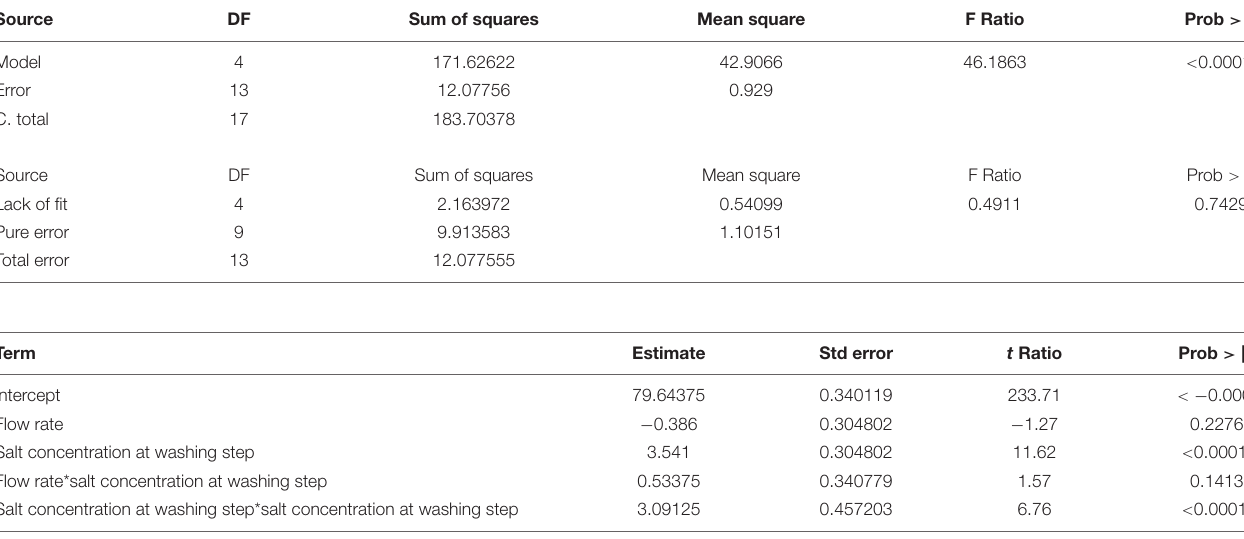
TABLE 2 | Regression analysis of predicted model for %Step yield.